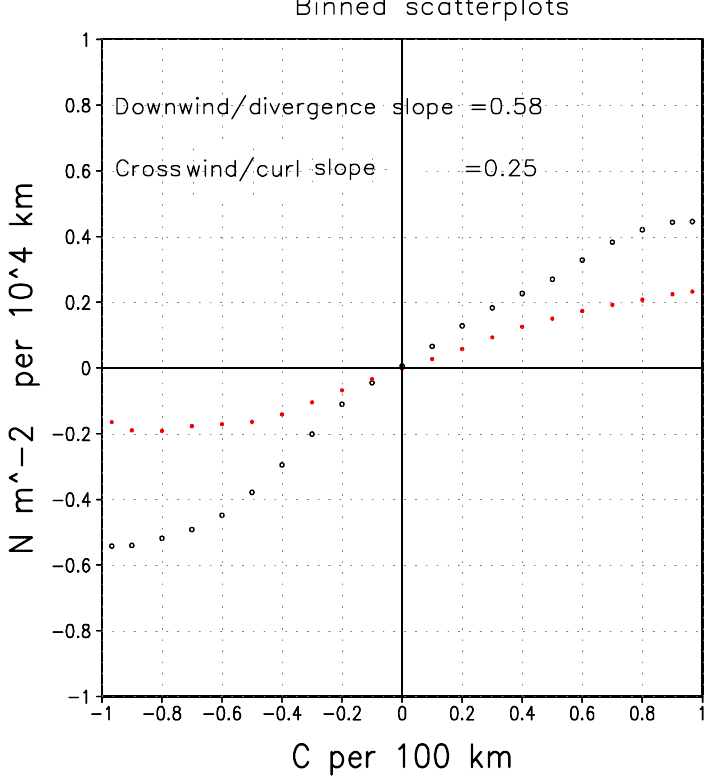
Figure 10. Binned scatterplots of the relationship between the zonal-high-pass filtered wind stress divergence and downwind component of the SST gradient (the black line with open circles), and the zonal-high-pass filtered wind stress curl and crosswind component of the SST gradient (the red line with close circles), which are computed over the region (0°N –5°N, 150° W –105°W) during the cold season (August–December). The y-axis unit is N·m −2 per 10 4 km and the x-axis unit is °C per 100 km,